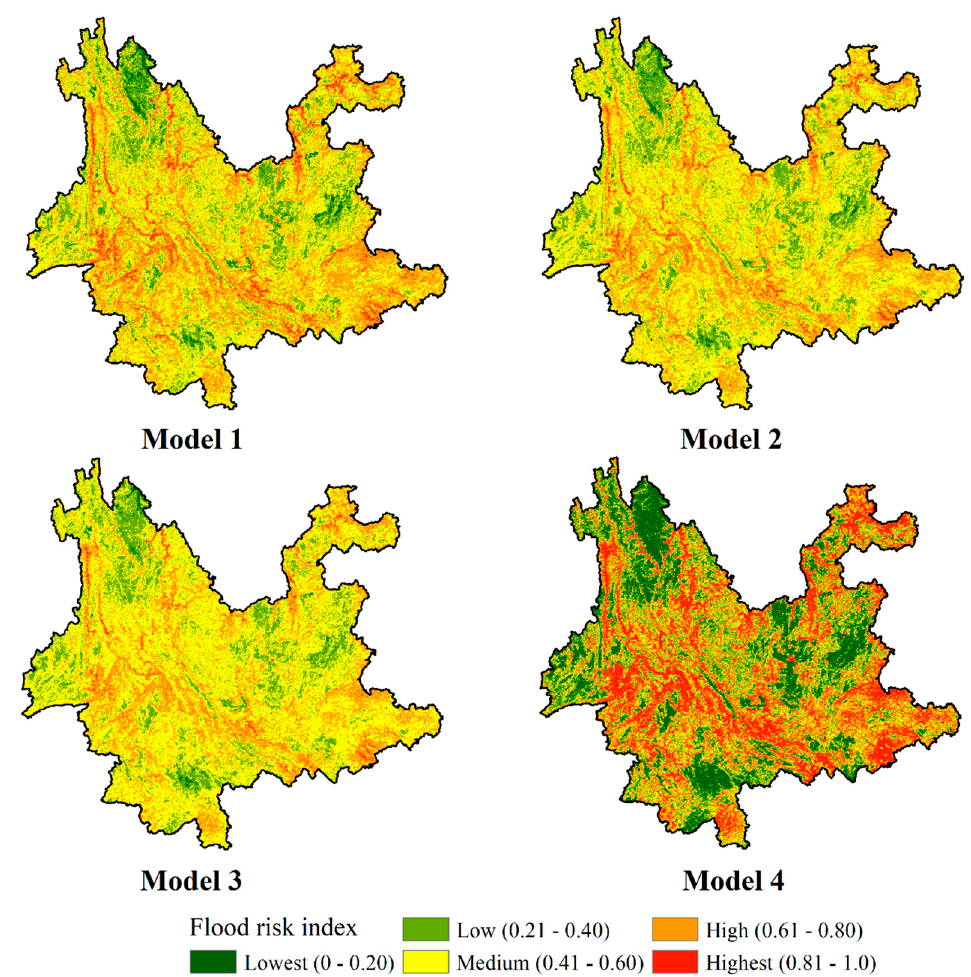
Figure 5. Flood risk index distribution of different models. (Model 1: LSSVM + LN, model 2: LSSVM + RBF, model 3: LSSVM + PL, model 4: LR).